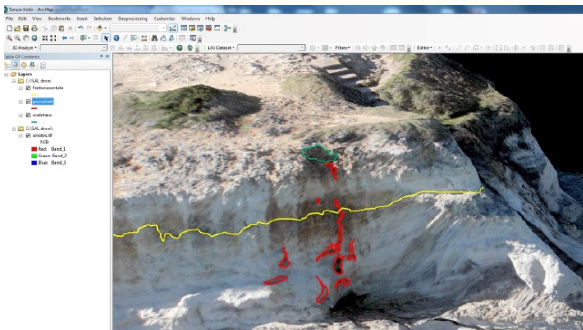
Figure 7: Details of the discontinuity lines